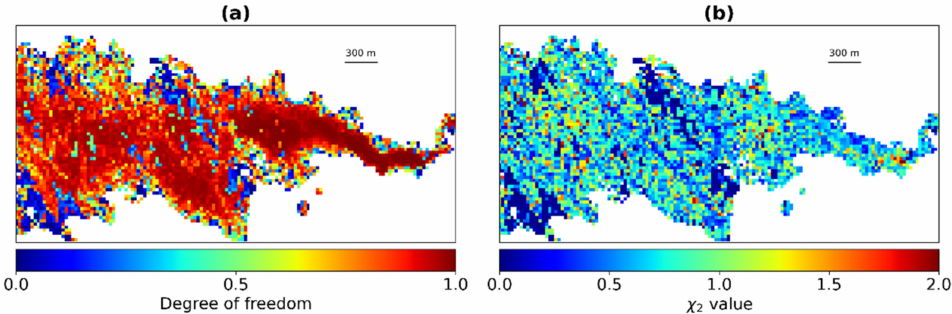
Figure 6. ( a ) Degree of freedom map for the 2020/07/21 image. The values tend towards 1.0; the a priori concentration is not dominant in the inversion step. ( b ) χ 2 map for the same image. The average χ 2 values are close to